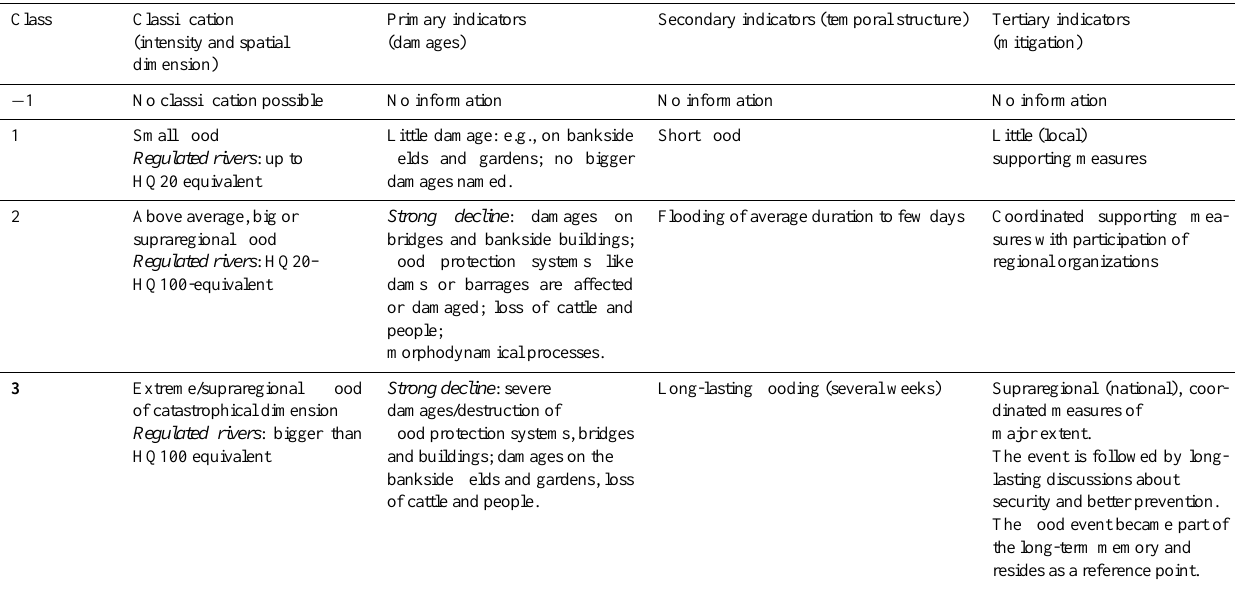
Table 1. Study area including the researched rivers and actual administrative districts in France and